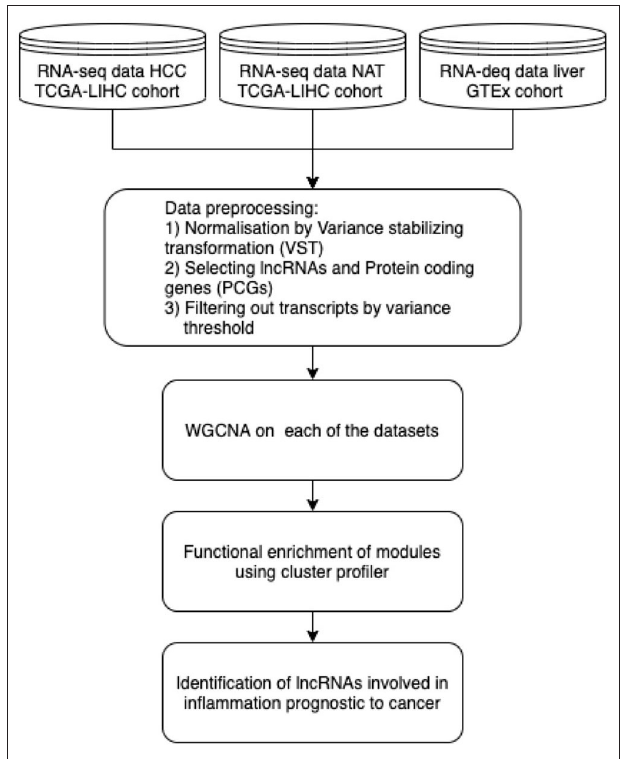
FIGURE 2 | RNA-seq-based co-expression network analysis pipeline for identification of lncRNAs in pathways dysregulated in HCC from the TCGA-GTEx